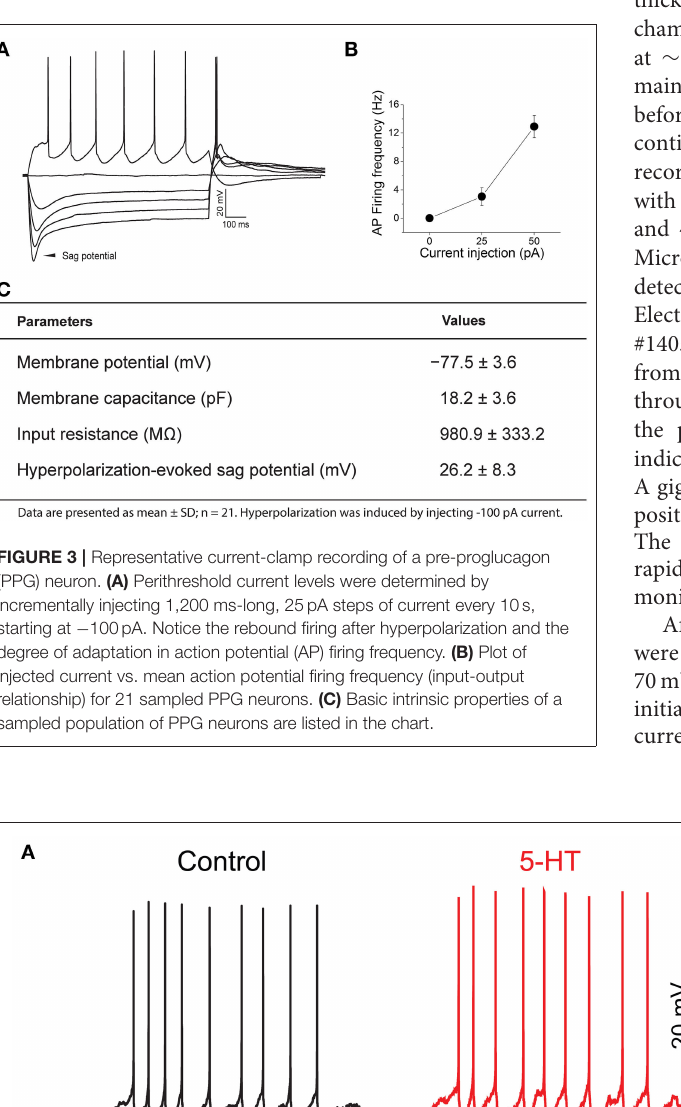
Frontiers in Cellular Neuroscience |